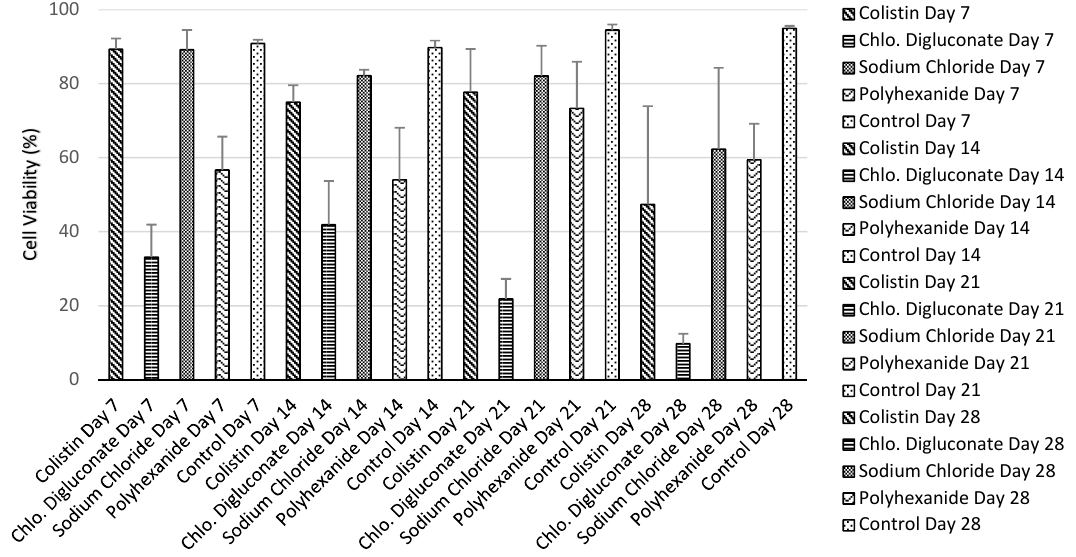
Figure 5. Bar graph of cell viability percentage media for each treatment and control at days 7, 14, 21, and 28. n = 3. No significant differences among the days of the evaluation period for each treatment were found (Figure 6). However, the analysis revealed significant differences among the different treatments in each day of the evaluation (Figure 7). Specifically, on day 7 of treat- ment (Figure 7a), there was a significant reduction in the cell viability after chlorhexidine digluconate compared to colistin ( p ≤ 0.001) and sodium chloride ( p ≤ 0.001) treatments, and the control (non-treated BASS ( p ≤ 0.001); and after polyhexanide compared to colistin ( p = 0.0272), sodium chloride ( p = 0.0282) treatments, and the control ( p = 0.0210). At day 14 (Figure 7b), there was only significant differences between chlorhexidine digluconate treatment compared to sodium chloride treatment ( p = 0.0472) and the control ( p = 0.0179). At day 21 (Figure 7c), cell viability was significantly lower after chlorhexidine digluconate treatment compared to colistin ( p = 00836), sodium chloride ( p = 0.00497), and polyhexa- nide ( p = 0.01415) treatments, and the control ( p = 0.00127). Lastly, at day 28 of the evalu- ation period (Figure 7d), there was a significant difference between chlorhexidine diglu- conate treatment and the control ( p = 0.0246). Therefore, compared to the control, chlor- hexidine digluconate followed by polyhexanide more affected cell viability than the other treatments after the antiseptic/antibiotic test.